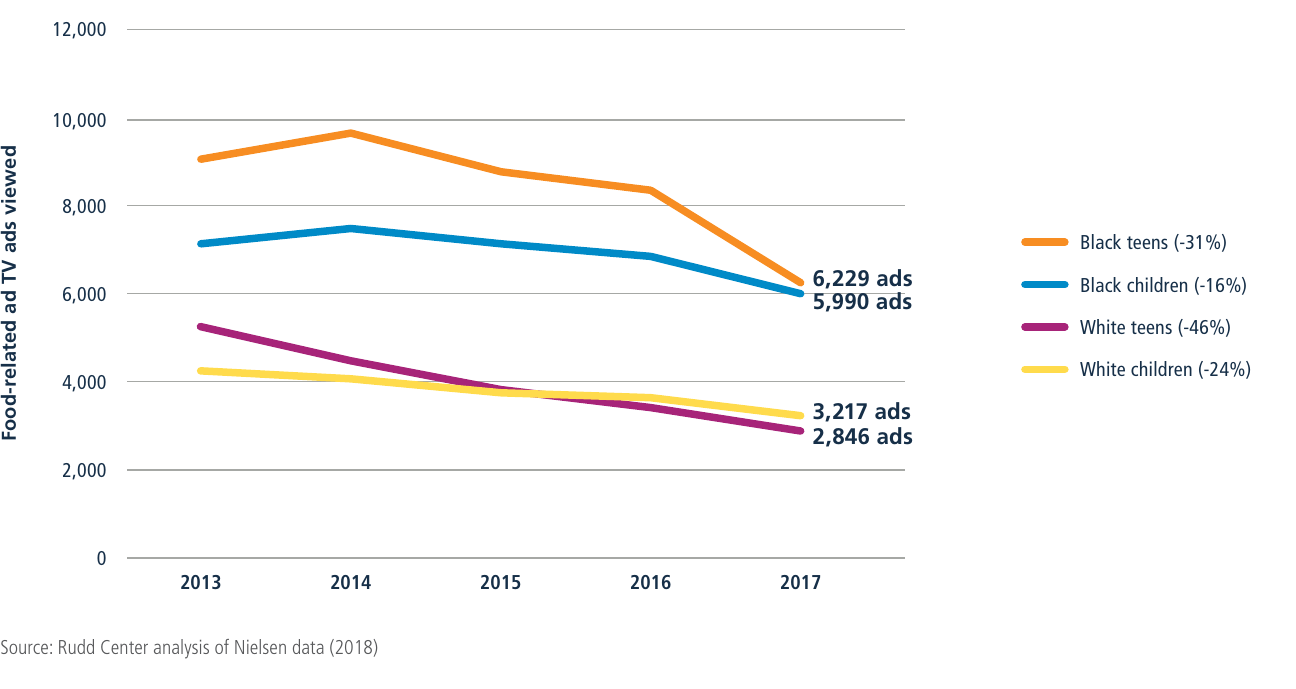
Source: Rudd Center analysis of Nielsen data